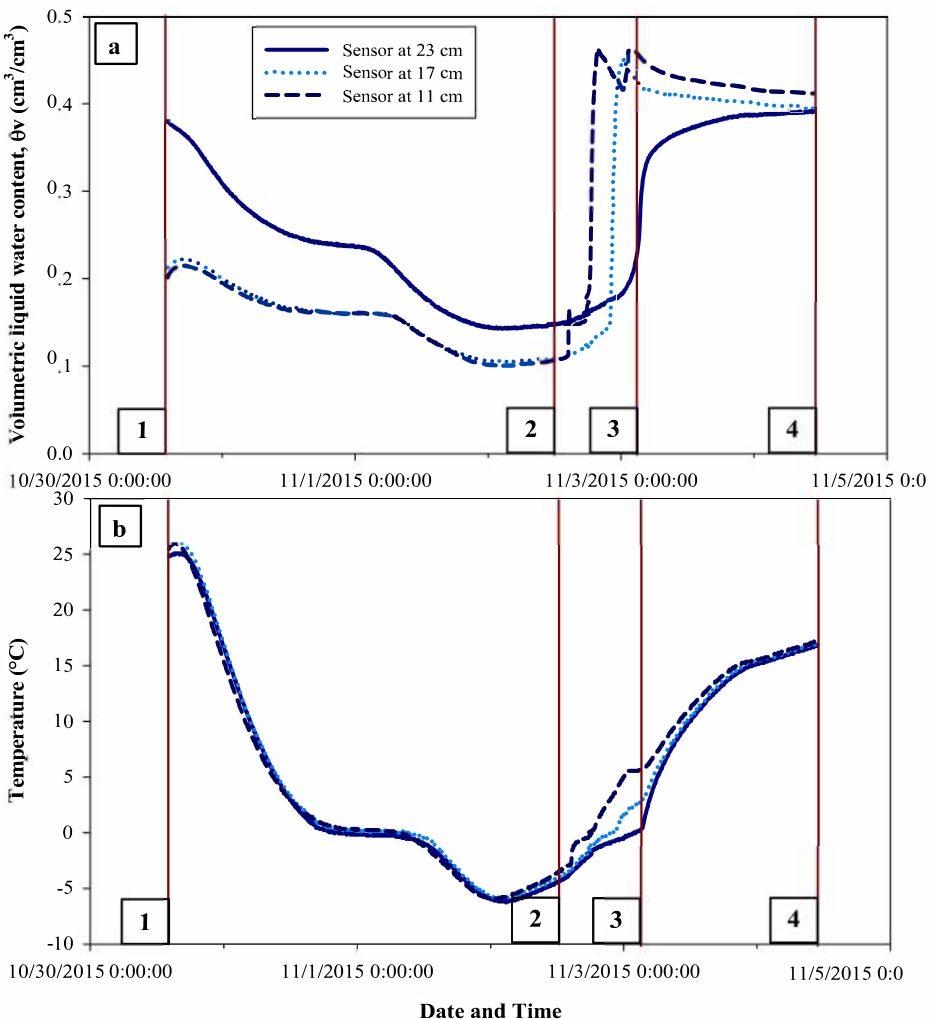
Figure 10. ( a ) Volumetric liquid water content ( θ v ) vs. time and ( b ) soil temperature vs. time, plotted for experimental Run 6 with initial water content conditions between permanent wilting point ( θ pwp ) and field capacity ( θ fc ). The vertical straight lines indicate (1) starting time of soil freezing and datalogging, (2) starting time of experimental run, (3) ending time of experimental run, and (4) ending time of